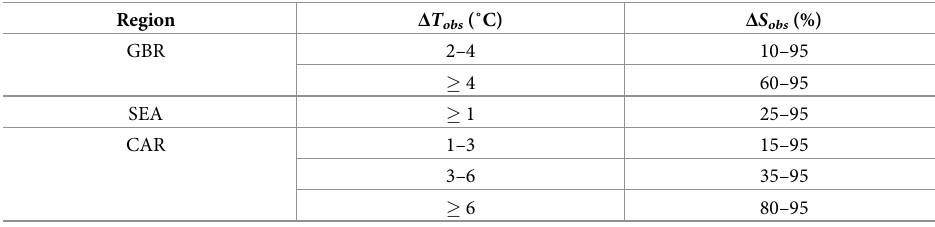
Table 2. Ranges of temperature increase ( Δ T ) and corresponding ranges of symbiont abundance reduction obs ( Δ S obs ) derived from observational data of temperature-induced bleaching (see S1 Appendix, for additional details).